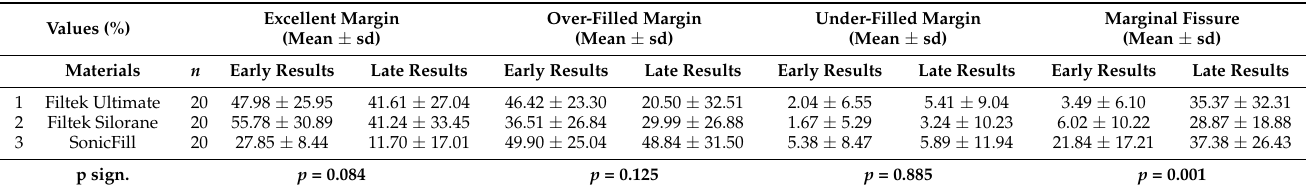
Table 6. Gingival marginal adaptation. Comparison of early and late results.